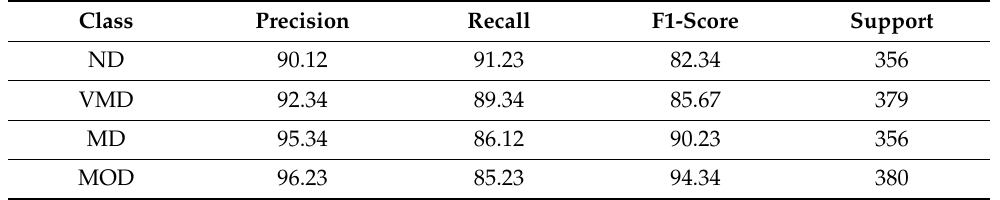
Table 4. Performance indices of individual